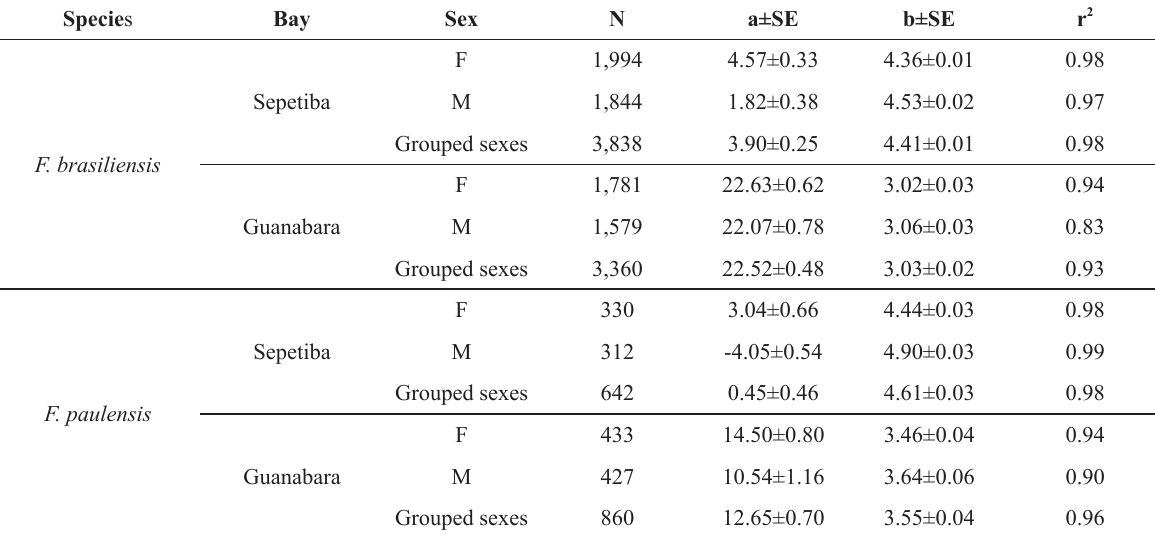
Parameter values of the equation TL=a+b.CL for each sex, species ( F. brasiliensis and F. paulensis ) and bay. Specie s